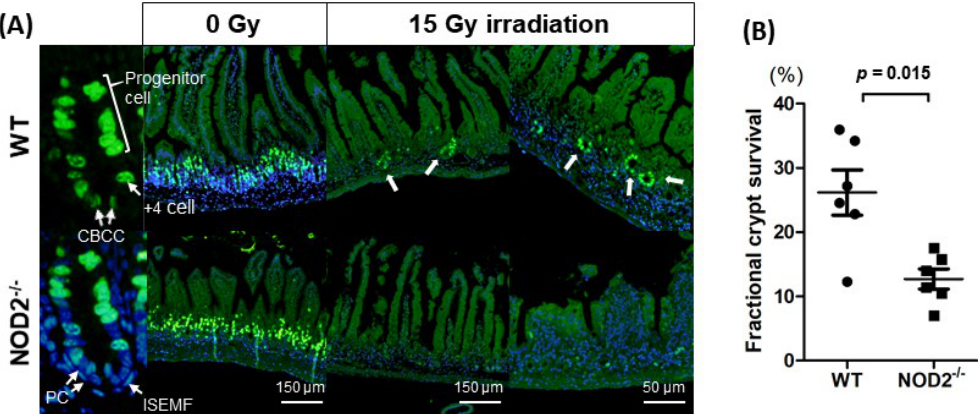
Figure 3. EdU assay in the WT and NOD2 −/− mice. ( A ) EdU assay of the small intestine after 15 Gy irradiation. Arrows indicated the surviving crypts. ( B ) Fractional EdU-positive crypt survival rate. Differences were evaluated by t -test. CBCC, crypt base columnar cell; PC, Paneth cells; ISEMF, intestinal subepithelial myelofibroblast.